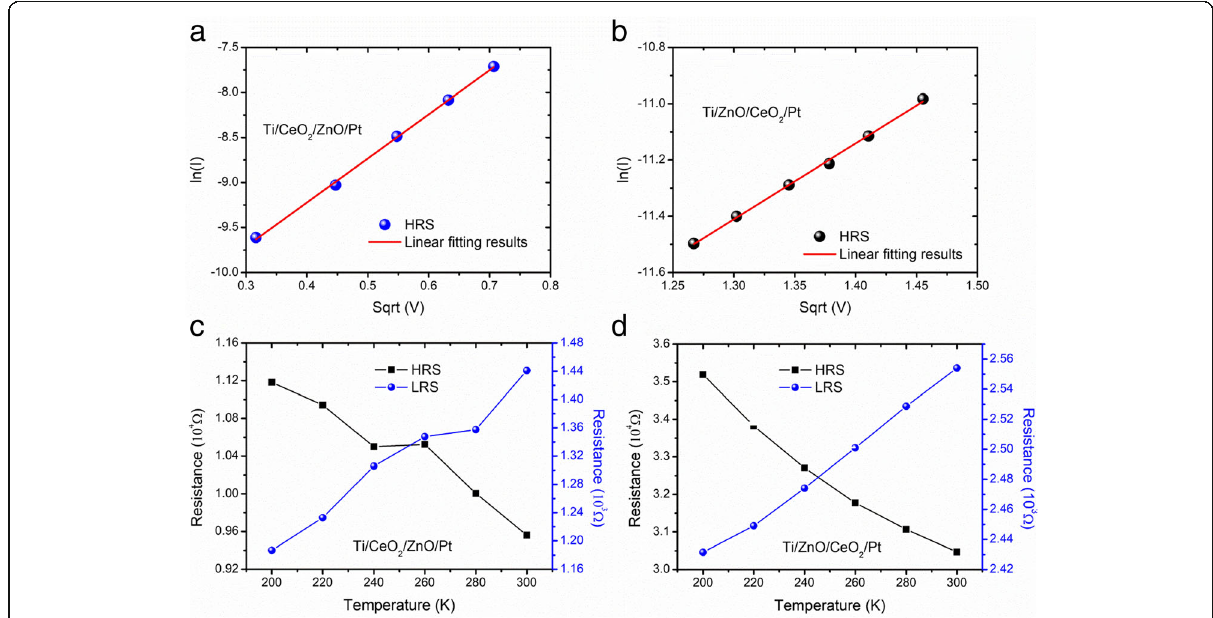
Fig. 6 log I-V 1/2 characteristics in the HRS of SET-state. a For Ti/CeO 2 − x /ZnO/Pt. b For Ti/ZnO/CeO 2 − x /Pt heterostructure memory devices. Temperature dependence of LRS and HRS of c Ti/CeO 2 − x /ZnO/Pt and d Ti//ZnO/CeO 2 − x /Pt heterostructure memory